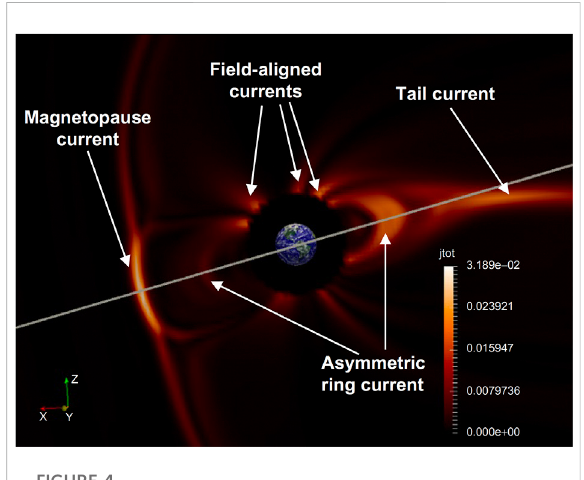
FIGURE 4 A meridional cut through the global 3D simulation domain showing the results for the total current density for 23 July 2015 geomagnetic storm. The main magnetospheric current systems are presented: the asymmetric ring current, tail current, magnetopause current, and fi eld-aligned currents (more visibleintheregionsofconvergingmagnetic fi eld).Thesunisfrom the left. The gray line is the projection of a plane through the approximate geomagnetic equator in the inner magnetosphere. Current density is shown in μ A/m 2 . From Buzulukova et al.,